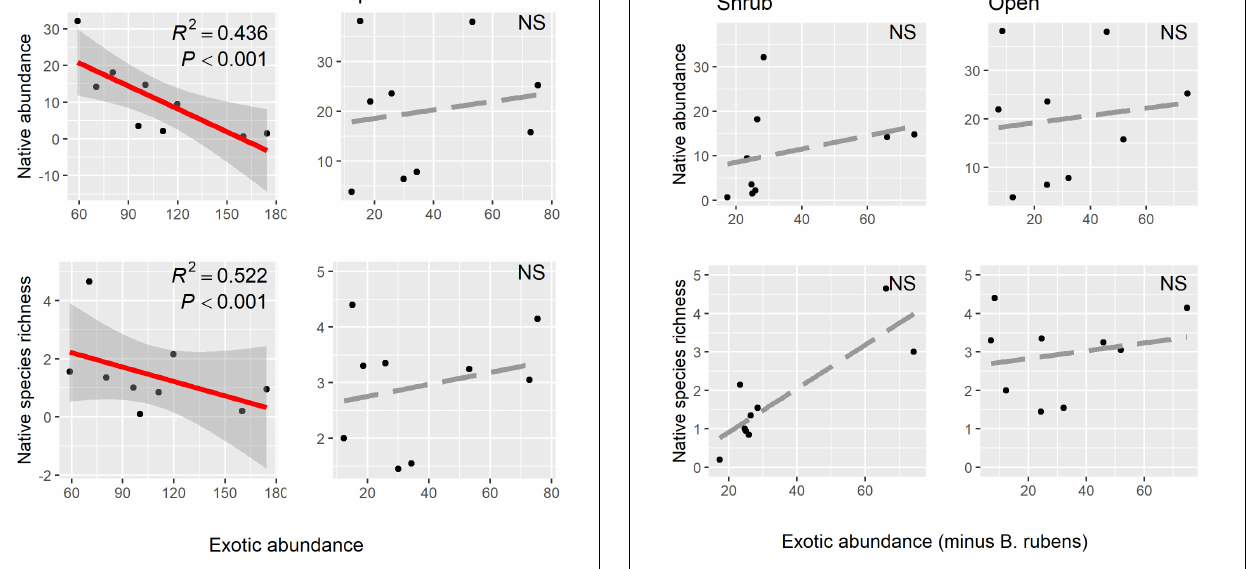
FIGURE 4 | Native abundance and native species richness (all native species combined) plotted against exotic abundance with B. rubens omitted from the data in shrub and open microsites. Note that there are no significant native-exotic relationships when B. rubens is omitted from the data.